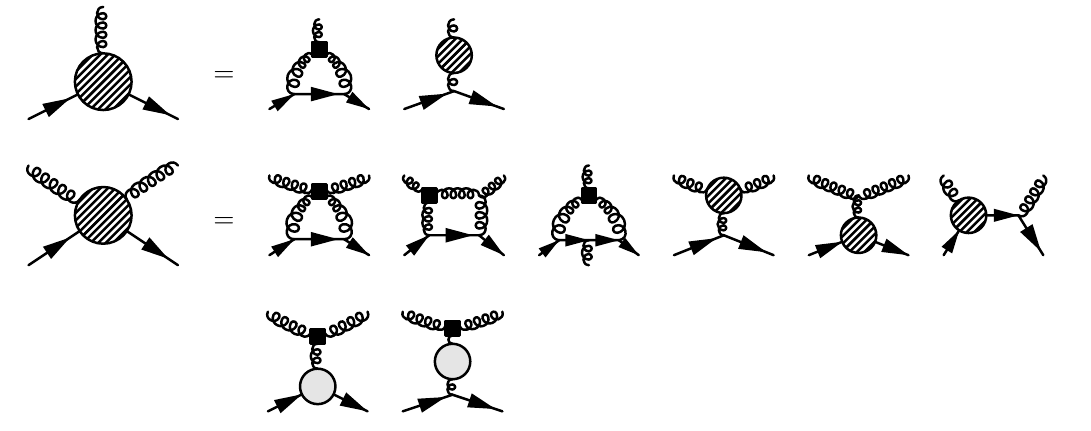
Figure 5 . Gluon two-point function (cid:5) (cid:11)(cid:12) insertion of the gCEDM operator O (1) gCEDM is shown.